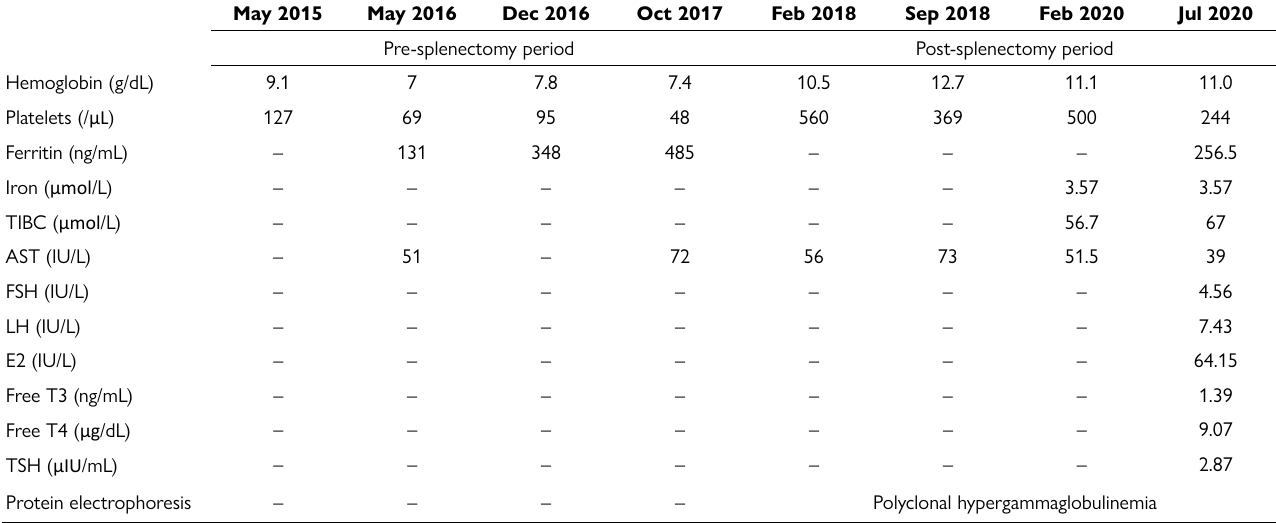
Table 1. Hematological and Biochemistry parameters.